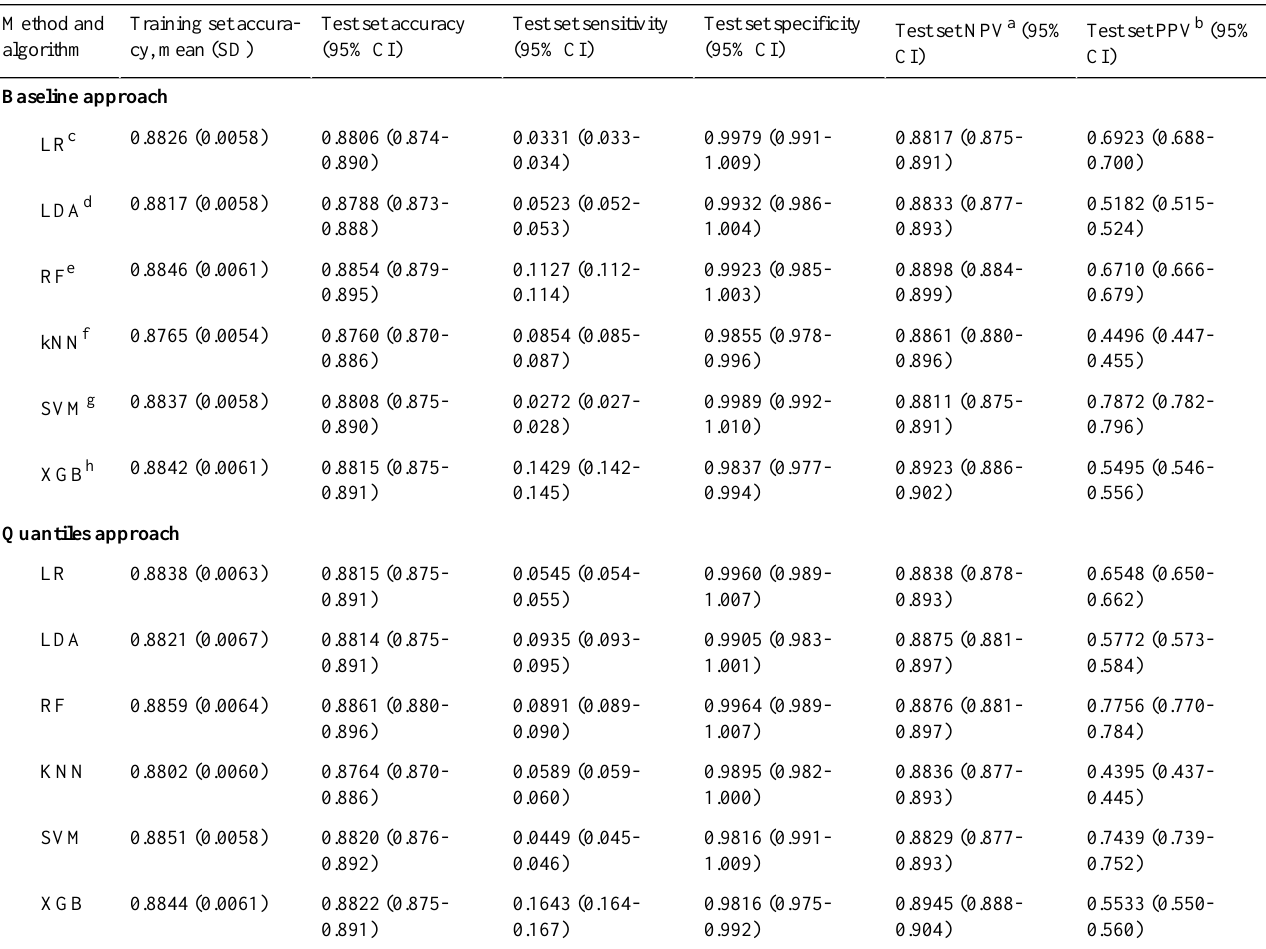
Table 8. Mortality model results for six algorithms using different performance